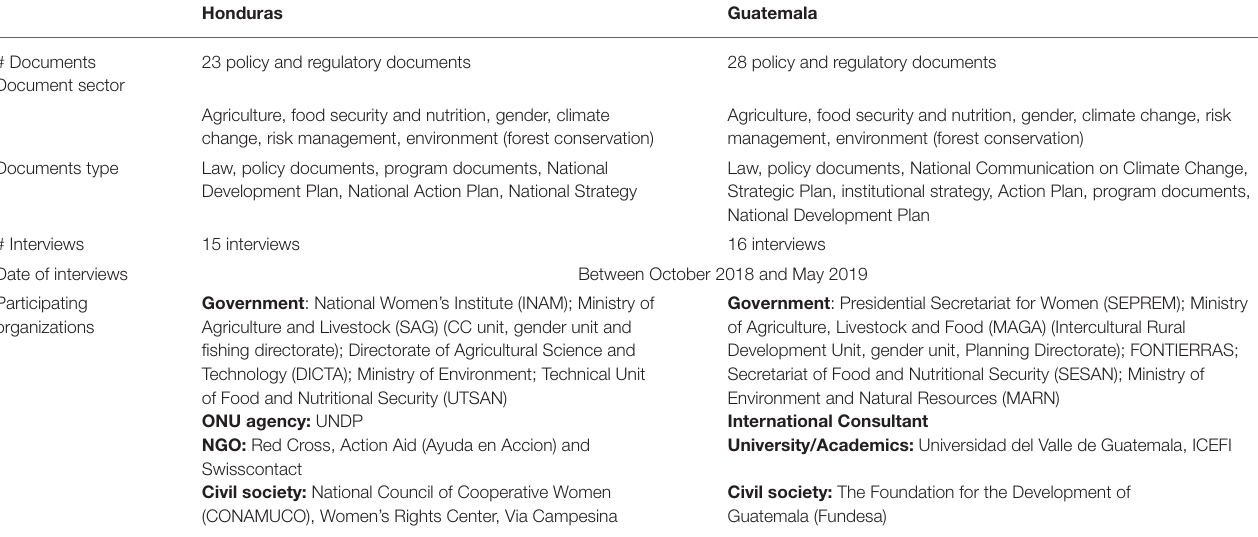
TABLE 1 | Sources of information for this